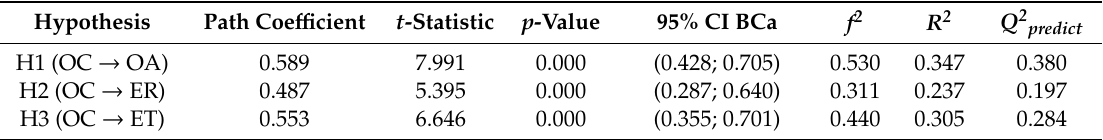
Table 3. Evaluating the research hypotheses and structural